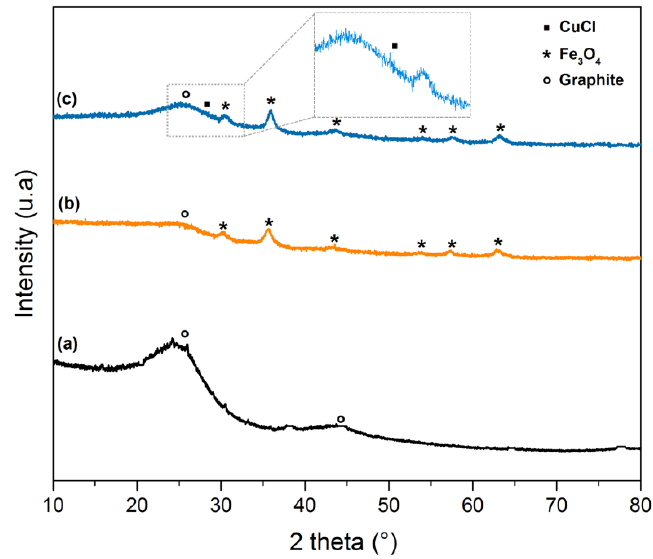
Figure 2. XRD spectra of PAC ( a ), Fe 3 O 4 -PAC ( b ), and Cu-Fe 3 O 4 -PAC ( c ).